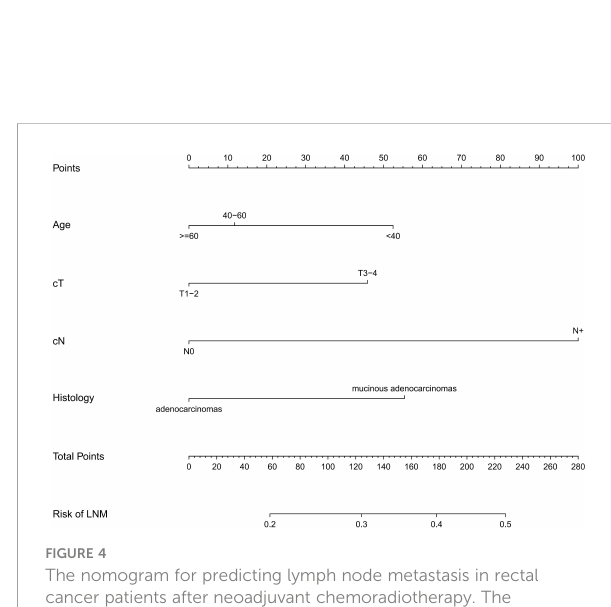
FIGURE 4 The nomogram for predicting lymph node metastasis in rectal cancer patients after neoadjuvant chemoradiotherapy. The nomogram was established in the training cohort using multivariable regression, consisting of age, cT(clinical T stage), cN(clinical T stage) and